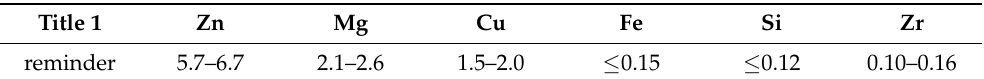
Table 1. Nominal composition of the investigated AA7010-T7452 alloy